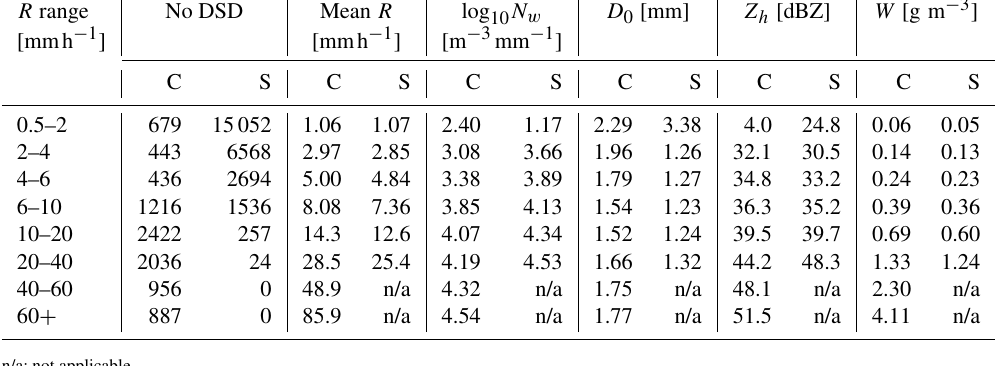
Table 1. Mean DSD parameters for given R ranges and BR09 convective-stratiform classification. R range